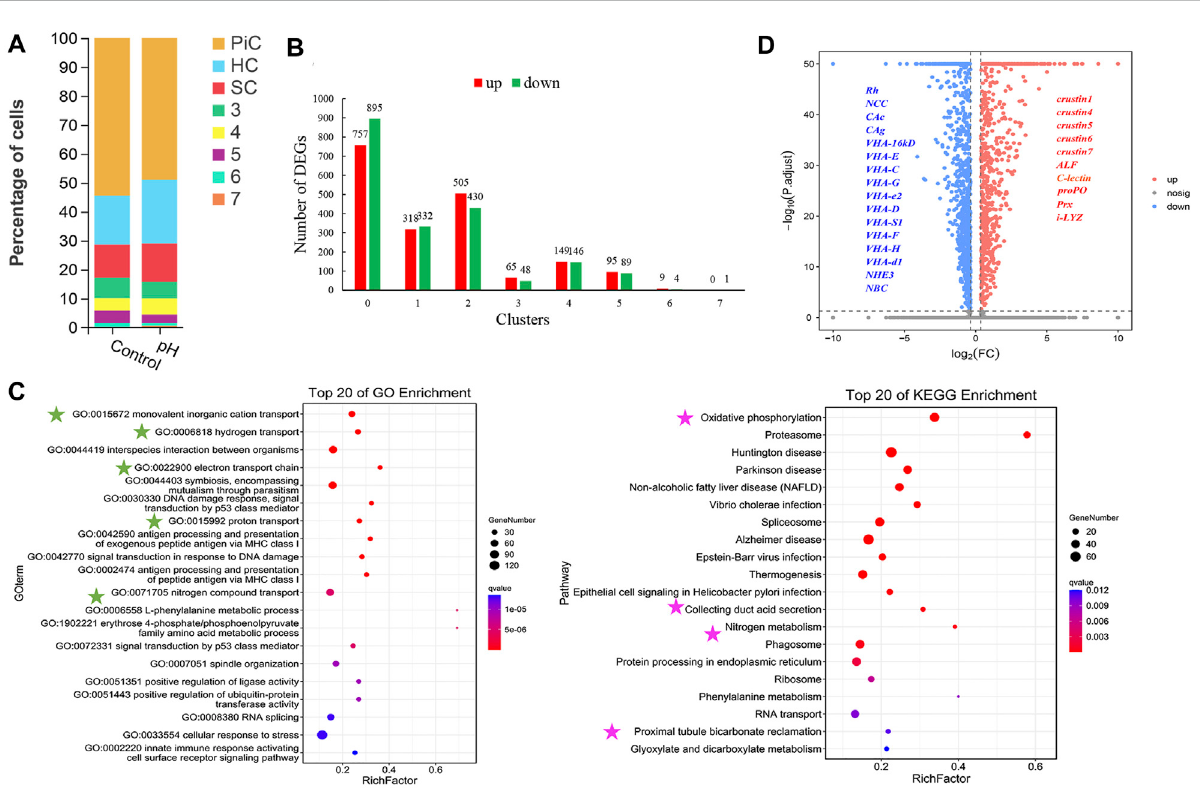
FIGURE 3 The changes of cell clusters under high pH stress and enrichment of DEGs. (A) The comparison of cell number ratios between control and pHgroups.Cluster0,1and2wereidenti fi edasPiC,HCandSC,respectively. (B) Up-anddown-regulatedDEGnumbersineachcelltypeofgillsafter high pH stress. (C) GO and KEGG enrichments of DEGs in pillar cells. The green stars indicated the GO terms related to ion transport, and the pink starsindicatedtheKEGGpathwaysrelatedtoiontransport. (D) Differentialgenevolcanicmapdisplayofpillarcells. ALF Anti-lipopolysaccharide factor, proPO prophenoloxidase, Prx peroxiredoxin, i-LYZ